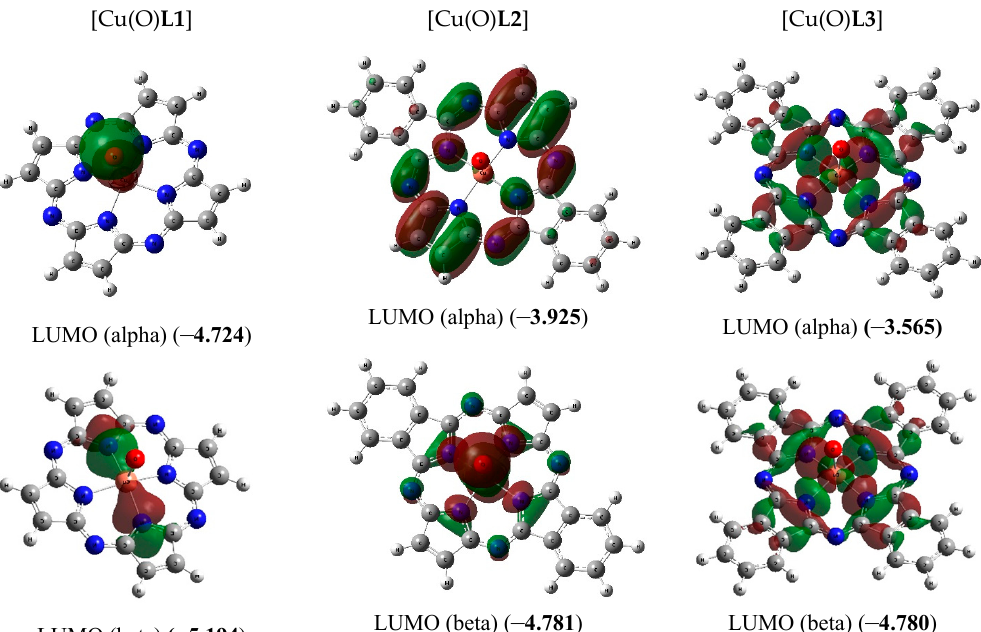
Figure 2. Molecular structures of Cu(IV) macrocyclic compounds of types ( a ) [Cu(O) L1 ] (ground state–spin doublet, M S = 2), ( b ) [Cu(O) L2 ] and ( c ) [Cu(O) L3 ] (ground state–spin quartet, M S = 4) found using DFT OPBE/TZVP method.